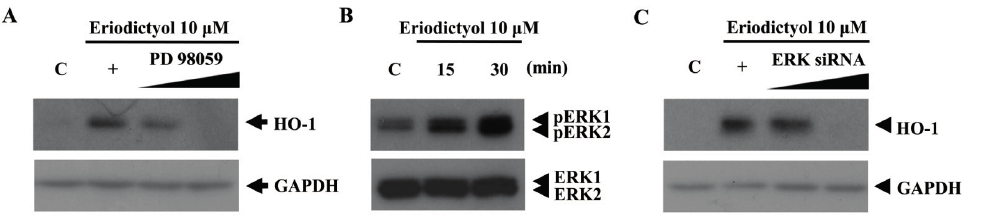
Figure 4. Blockage of eriodictyol-induced HO-1 protein expression by an ERK inhibitor. ( A ) Cells were pre-treated with increasing doses of PD 98059 (an ERK inhibitor) for 1 h prior to the treatment of eriodictyol 10 μ M; ( B ) cell lysates were immunoblotted with antibodies against the phosphorylated form of ERK1/2 and total ERK; and ( C ) transient transfection of cells with increasing doses of ERK siRNA (20 and 30 nM) inhibited the induction of HO-1 protein expression by eriodictyol 10 μ M. Western blots representative of three independent experiments are shown: C, untreated cells; +, treated with eriodictyol only; black line, treated with 10 µM eridictyol;